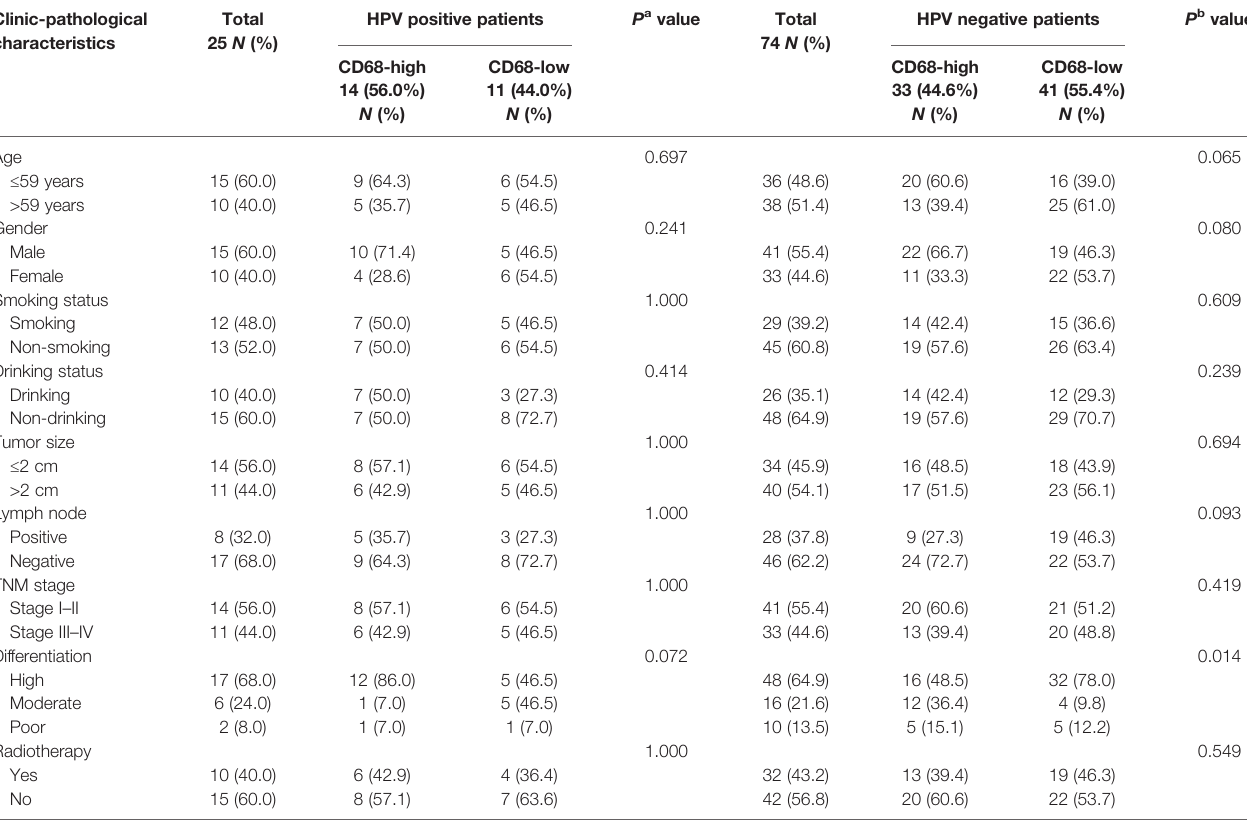
TABLE 1 | Correlation of intratumor CD68 + macrophage in fi ltration with clinic-pathological characteristics of HPV positive and negative OSCC patients in our cohort. Clinic-pathological